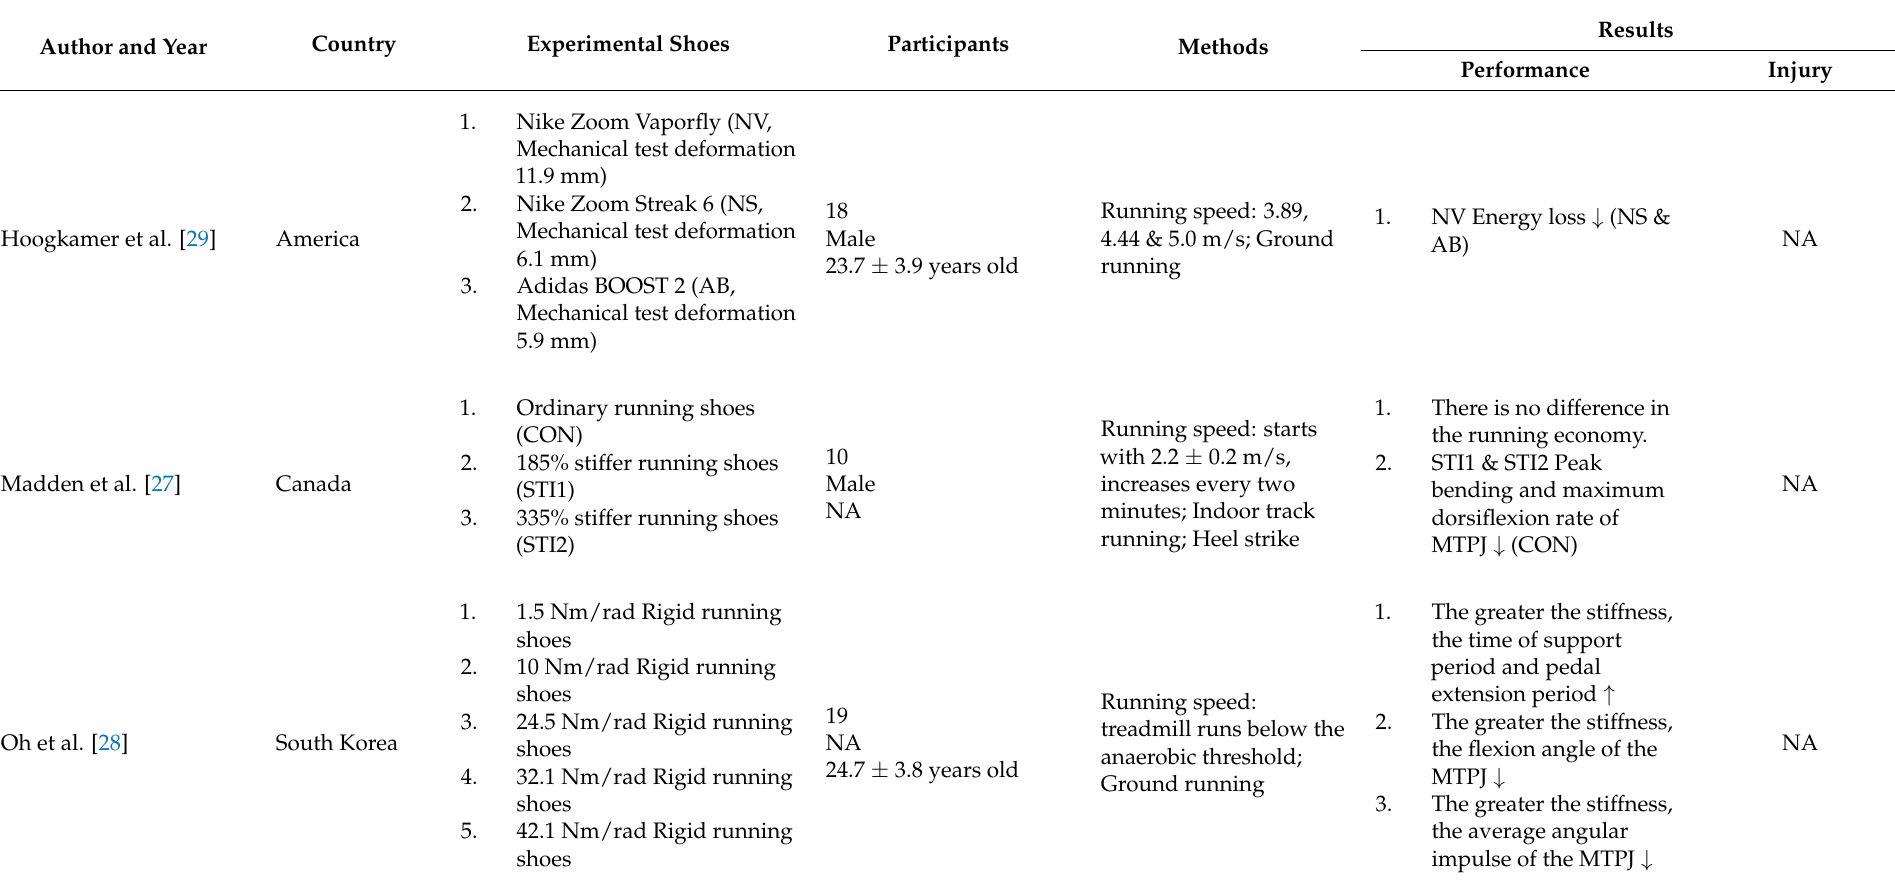
Table 2. The influence of longitudinal bending stiffness on running performance and related